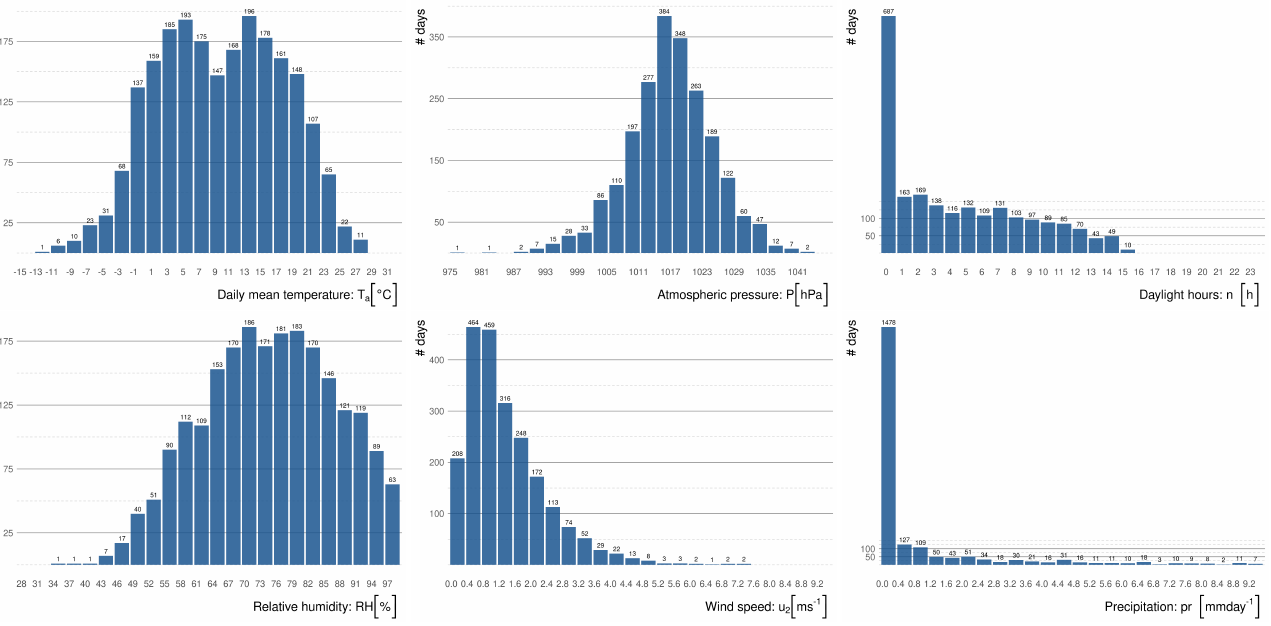
Figure 2. The basic statistics of the daily measurements performed at the Kopisty weather station during the years 2015–2019: average day temperature T a , atmospheric pressure P , daylight hours per day n , relative humidity RH , wind speed u 2 , and precipitation pr . These data are used in the equations for modelling the